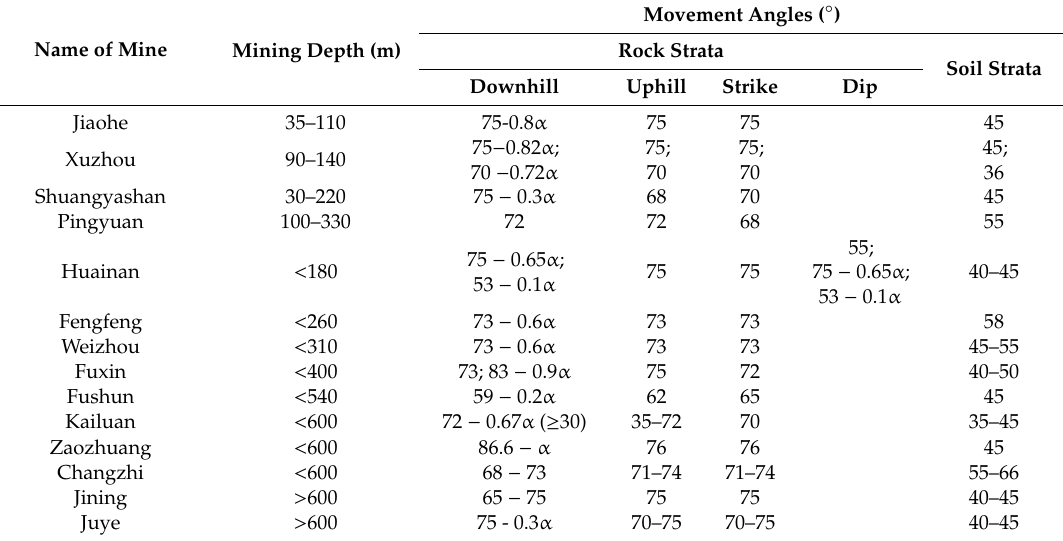
Figure 1. The ratio of soil thickness to total depth of the shaft. Table 1. The movement angles of some mine areas in